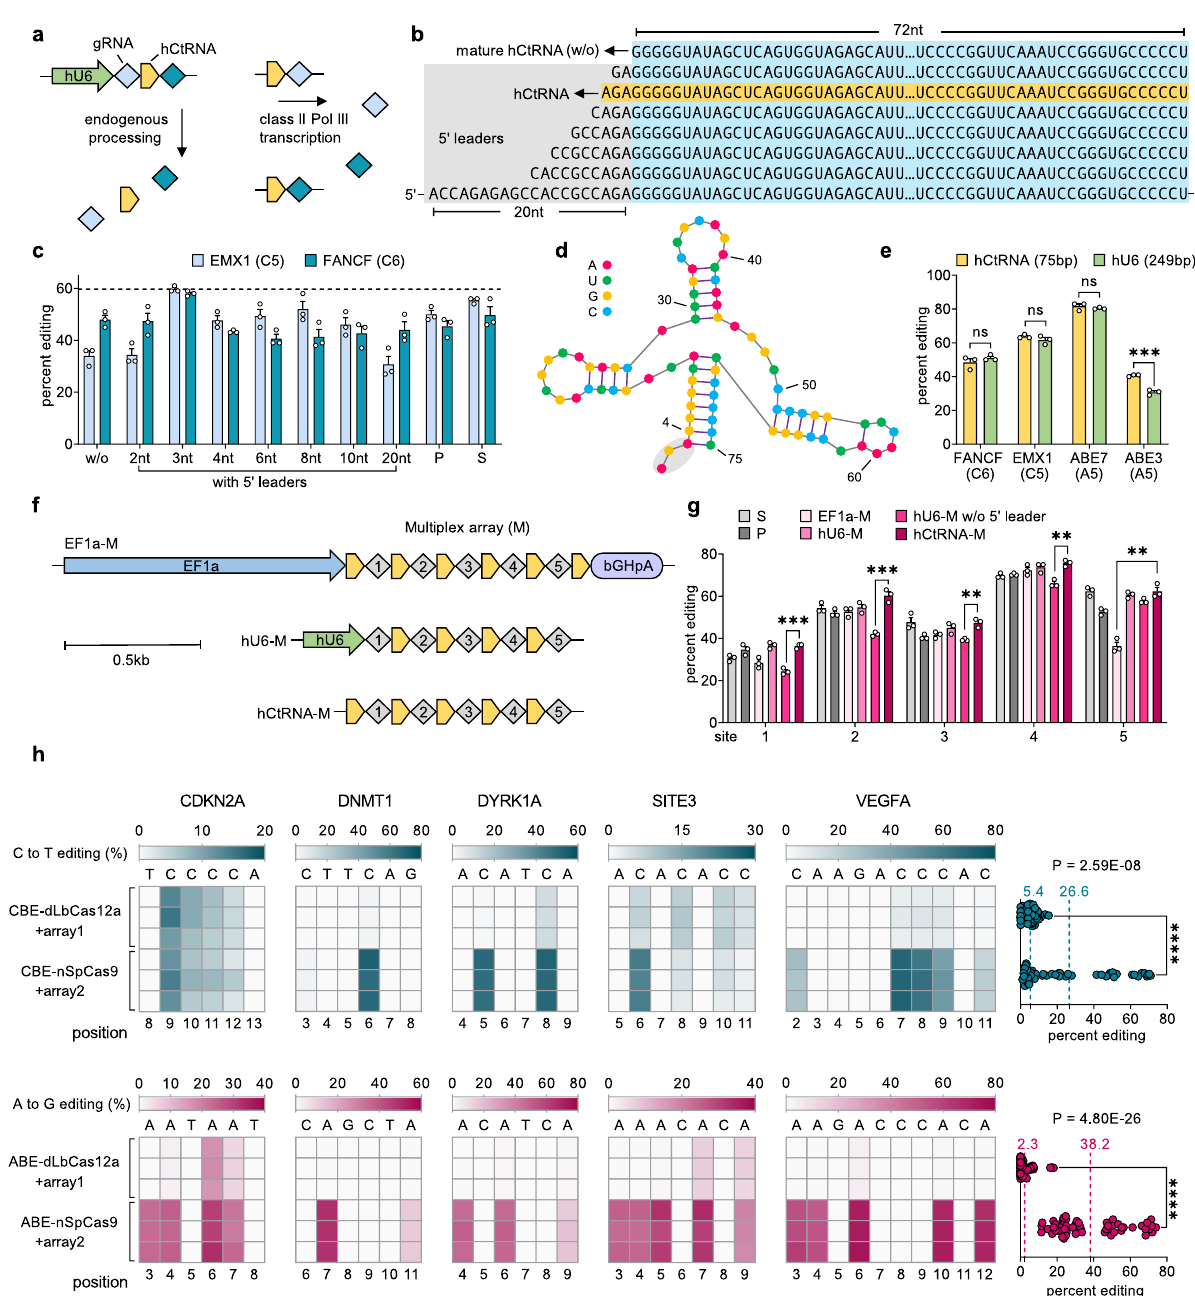
Fig. 2 Development of DAP strategy for MBE. a Schematic of 2-loci hCtRNA-gRNA array driven by hU6 and using hCtRNA as Pol III promoter. hU6, human U6 promoter (RNA Pol III). b 5 ′ leader engineering of hCtRNA. c Adding 3 nt 5 ′ leader to mature hCtRNA (72 nt) showing ef fi cient 2-loci hU6- driven MBE. P, pooled gRNAs; S, single gRNA; CBE used, NBE4max (R33A + K34A). d , Secondary structure of hCtRNA, gray shadow showing 3 nt 5 ′ leader. e , hCtRNA in comparison with hU6 as gRNA promoter for single-guide BE. CBE used, NBE4max (R33A + K34A); ABE used, ABE7.10 (F148A). f , g Ef fi cient 5-loci MBE using hCtRNA-M without additional upstream RNA Pol II (EF1a) or Pol III (hU6). hU6-M w/o 5 ′ leader, using mature hCtRNA (72 nt) in the hU6-M array. bGHpA, bovine growth hormone poly-A termination signal. h Comparison of nSpCas9-MBE and dLbCas12a-MBE. Data of dLbCas12a-MBE is from Fig. 1. Heat maps show 3 independent biological replicates at each condition, counting 1 as the most PAM-distal position. Dashed line showing mean value. c , e , g were analyzed using Sanger sequencing, h was analyzed using NGS. Error bars represent mean ± s.e.m. from n = 3 replicates ( e , h use unpaired two-tailed t -test; g uses unpaired multiple t-test; ns, not signi fi cant; * P < 0.05; ** P < 0.01; *** P < 0.001; **** P < 0.0001). All tests were performed in HEK293T cells. Multiple t -tests information is available in Supplementary Table 4. Detailed protospacers, edited bases, and amplicons of the relevant fi gures are available in Supplementary Table